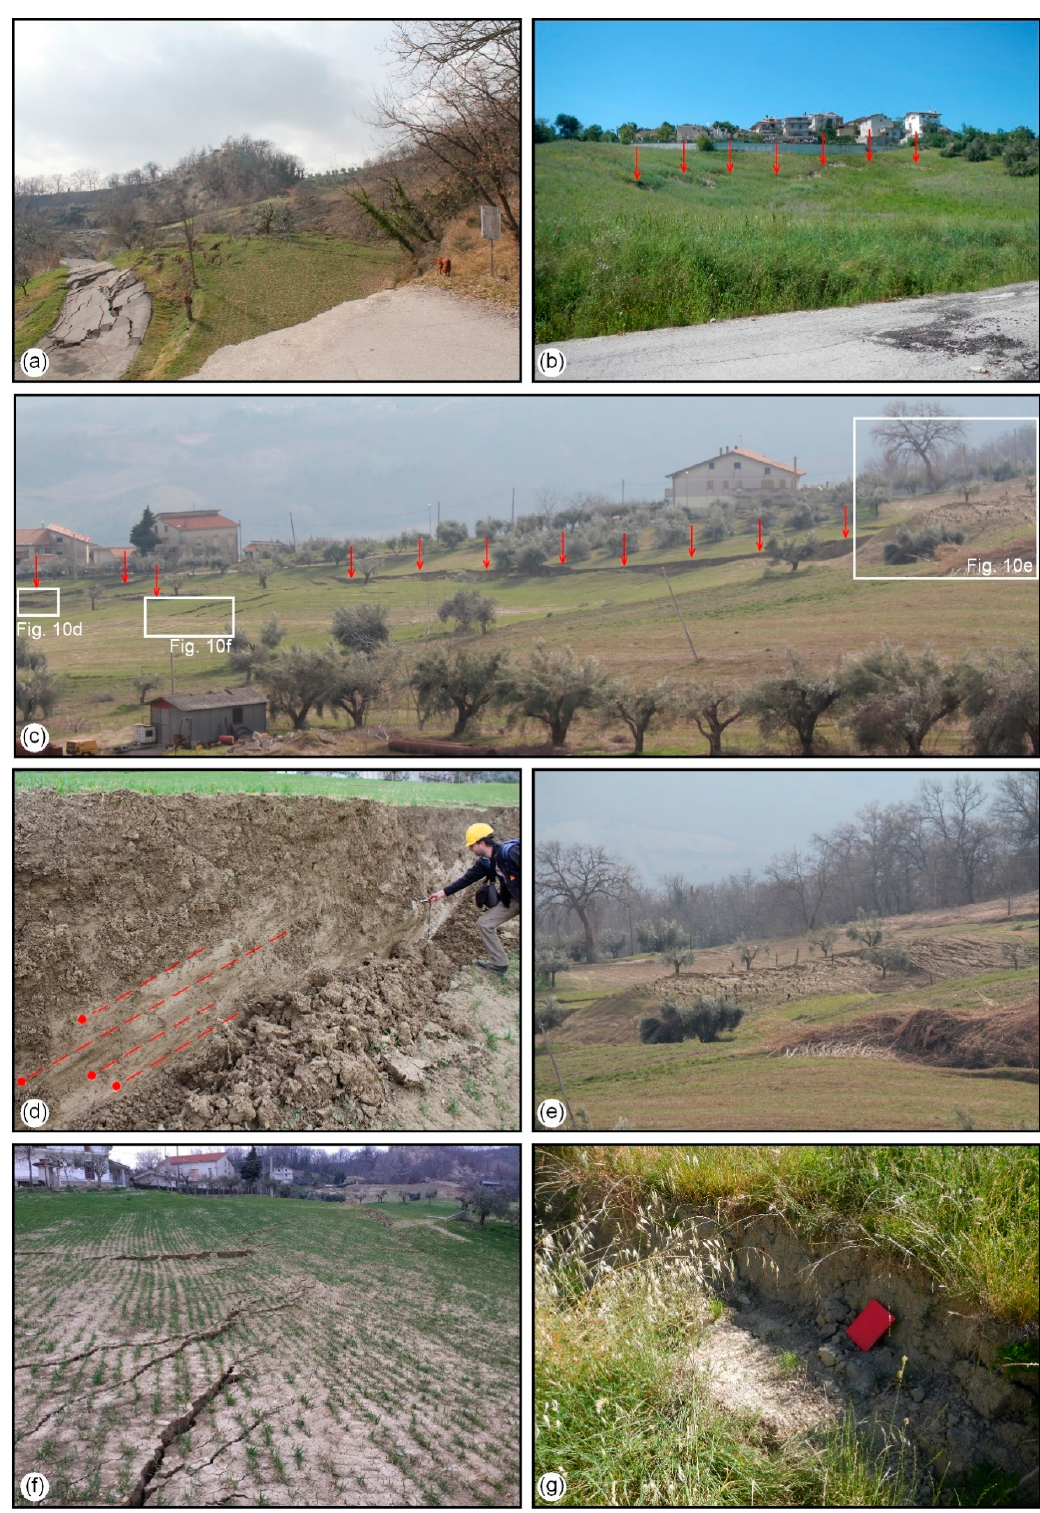
Figure 10. Geomorphological features of the Ponzano landslide. ( a ) upper part of the main southern scarp (up to >10 m high); ( b ) main northern upper scarp close to the Ponzano village (up to 5 m high); ( c ) lateral scarp in the southern side of the landslide; ( d ) detail of the lateral scarp, with groves outlining the translational movement; ( e ) push ridges on the southern lateral scarp; ( f ) tension cracks in the mid part of the landslide; ( g ) minor scarps in the mid-lower part of the landslide.